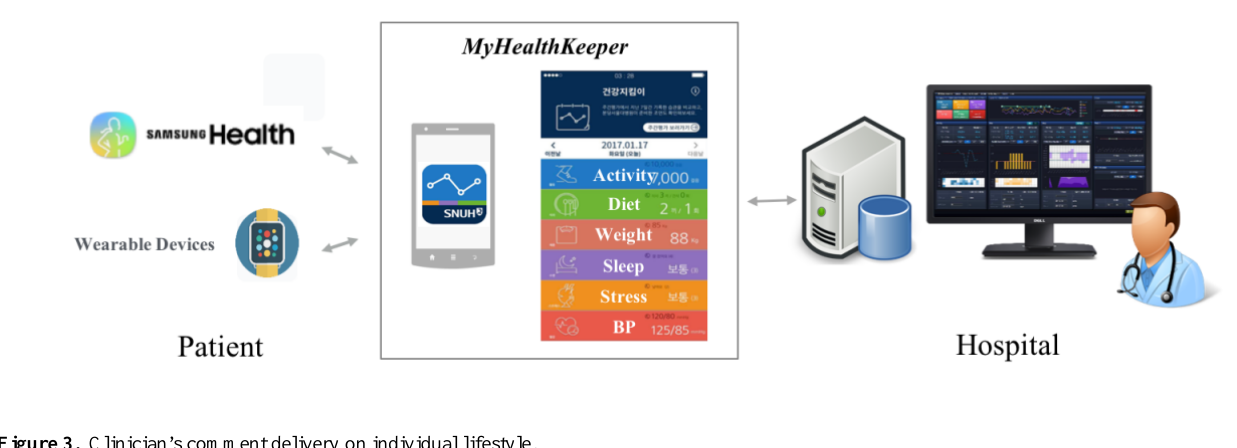
Figure 2. MyHealthKeeper personal health record development.